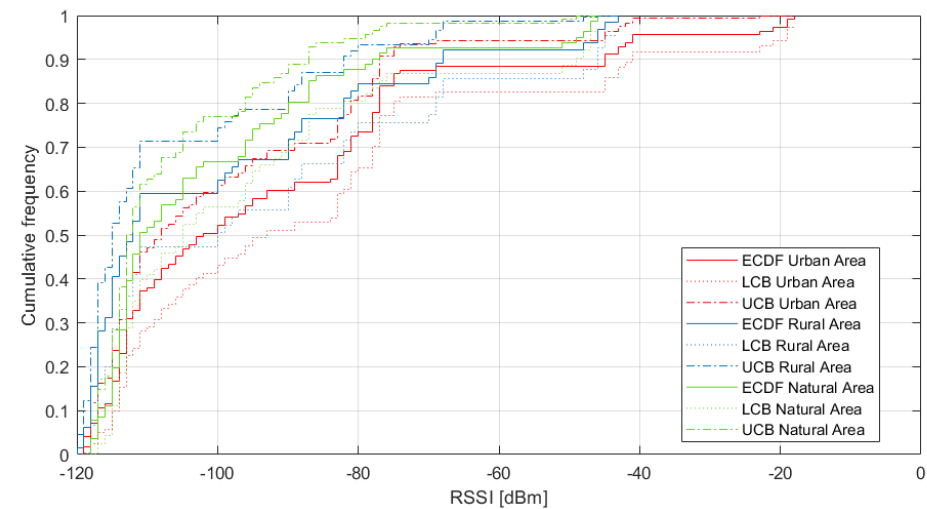
Figure 13. Empirical CDF of RSSI measurements.